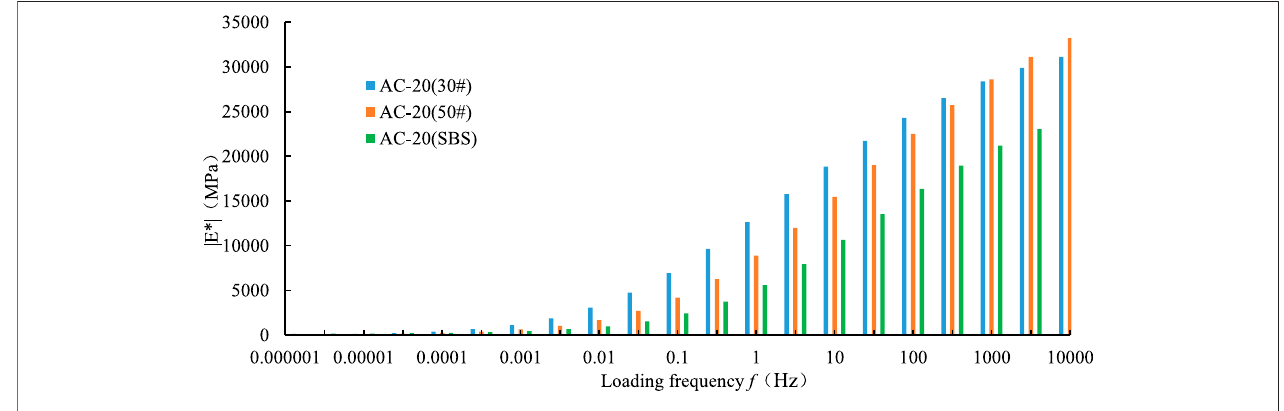
FIGURE 4 | Dynamic modulus of AC-20 asphalt mixture under different loading frequencies.